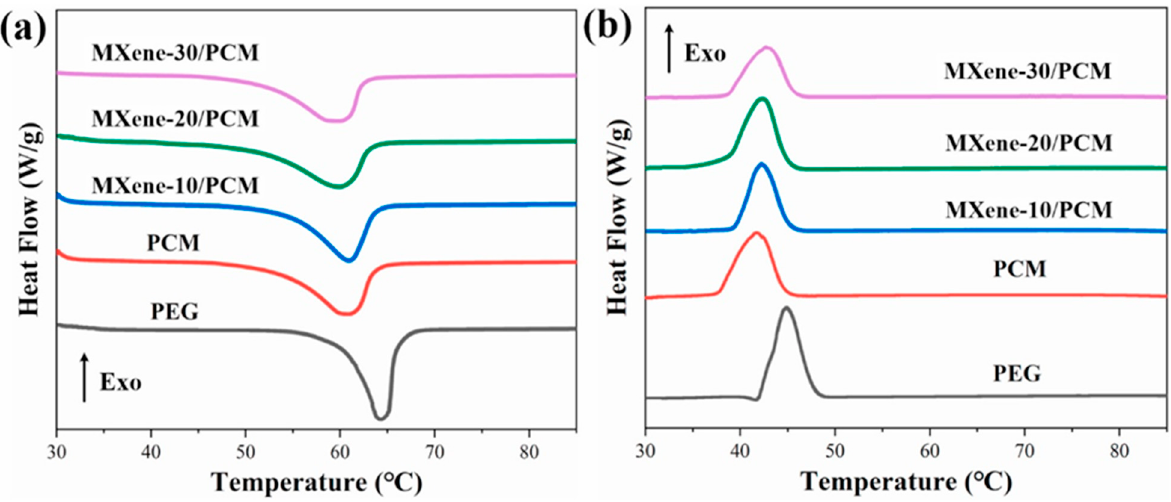
Figure 7. DSC curves of PEG, PCM, and MXene/PCM: ( a ) heating process and ( b ) freezing process [95].